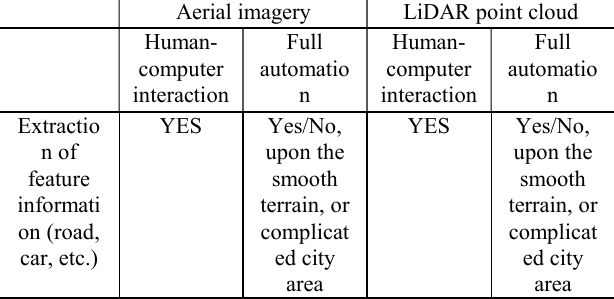
Table 2: Comparison analysis for feature information extraction from aerial imagery vs. LiDAR data